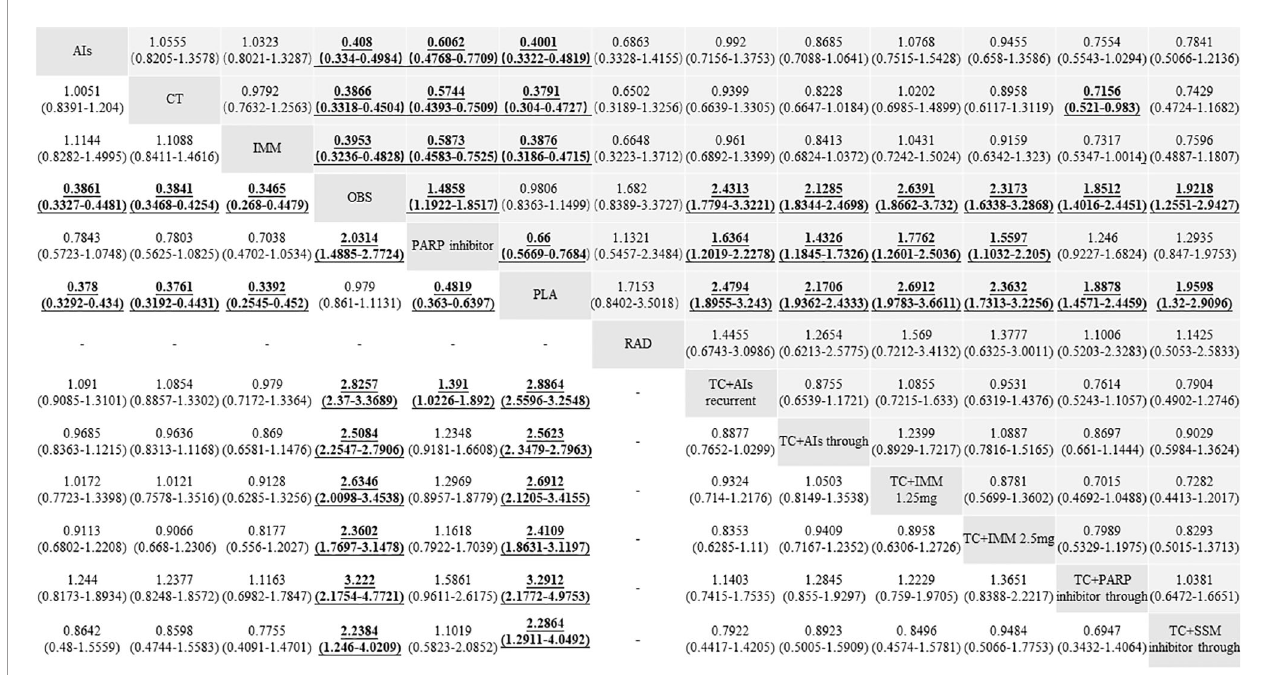
FIGURE 5 | Hazard ratios (HRs) and 95% con fi dence intervals (95% CIs) of ef fi cacy among the maintenance therapies of ovarian cancer patients between progression-free survival (PFS, up) and overall survival (OS, down). Comparisons between treatments should be read from left to right, and the estimate is in the cell in common between the column-de fi ning treatment and the row-de fi ning treatment. For ef fi cacy, HR lower than 1 and 95% CI not including 1 favor the row-de fi ning treatment of PFS or the column-de fi ning treatment of OS. To obtain the HRs for comparisons in the opposite direction, reciprocals should be taken. Signi fi cant results are in bold and